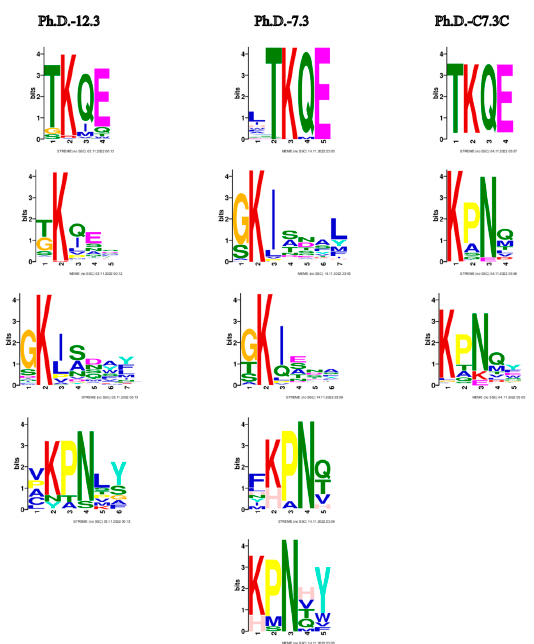
Figure 5. Motifs from biopanning rounds of three phage display libraries. Common motifs shared among the libraries appear to be TKQE, GKI and KPN. Only motifs with p < 0.05 are represented. Default parameters with the exception of minimum width: 3 were used. The enriched motifs are the potential constituents of epitope-like peptides.